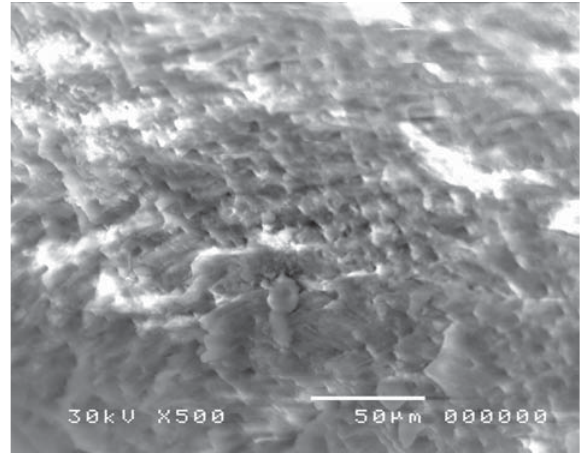
Figure 11- Electron-micrograph in gamma and laser (GL) group showing irregular dentine surface after cavity preparation. The tubular structure is maintained in most areas and reveals variation in tubular diameter (x2,000)